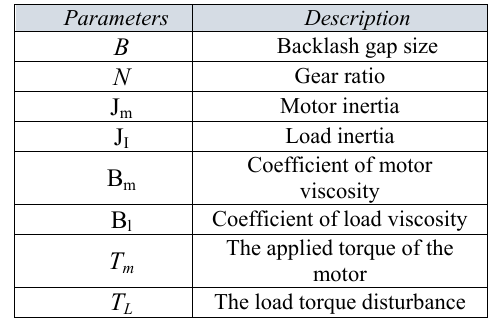
Table 1. The parameters of the two-mass system connected by a gearbox [34]